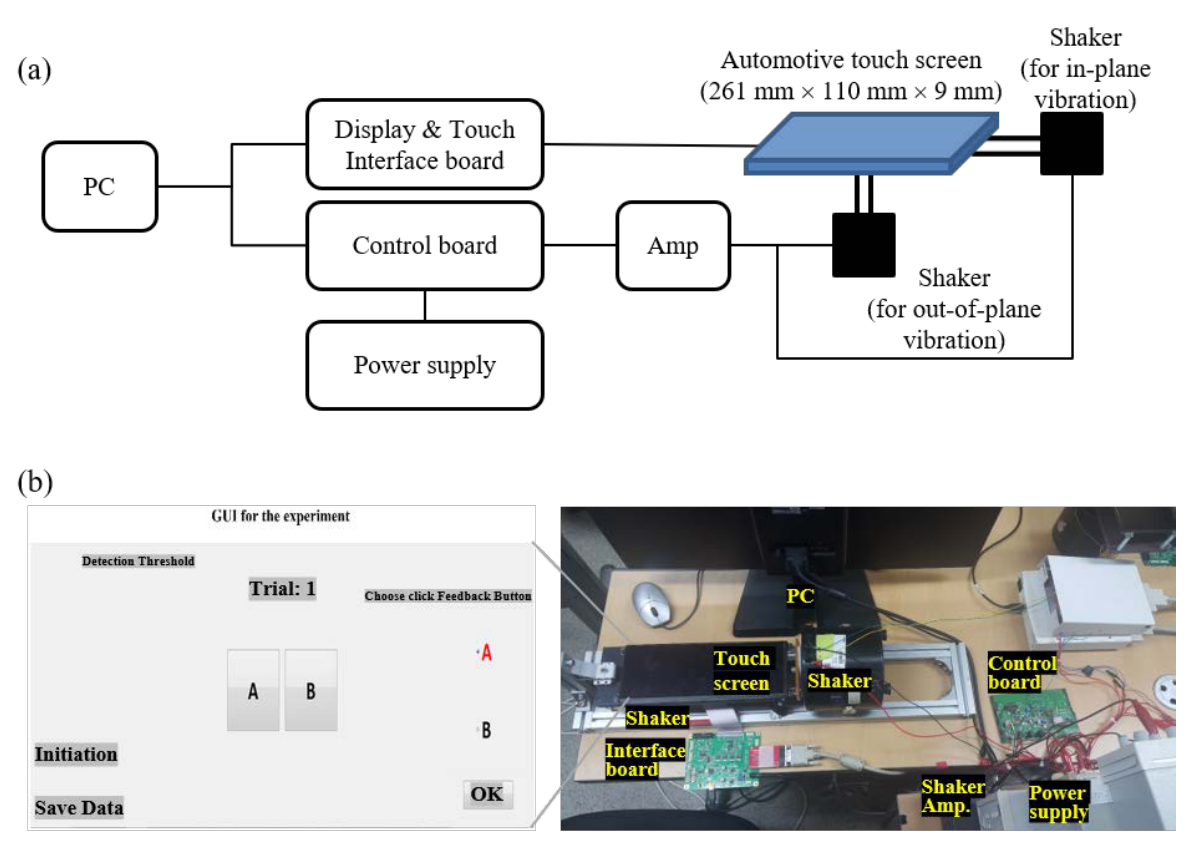
Figure 1. Experimental setup. ( a ) Schematic representation of the experimental setup. ( b ) Image of the experimental setup and